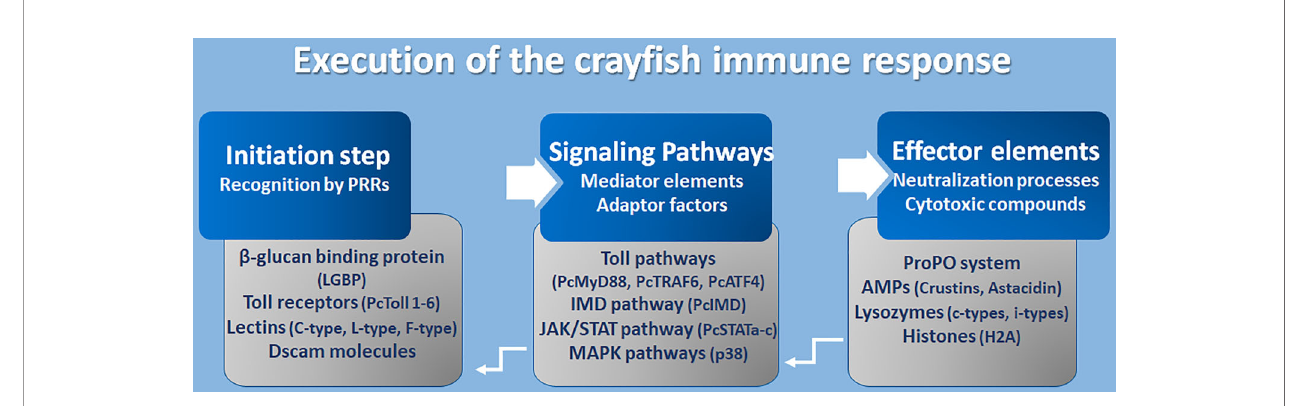
FIGURE 4 | Execution of cray fi sh immune response. Coordination of the immune response at molecular level (8, 16, 17, 97, 106, 120 –